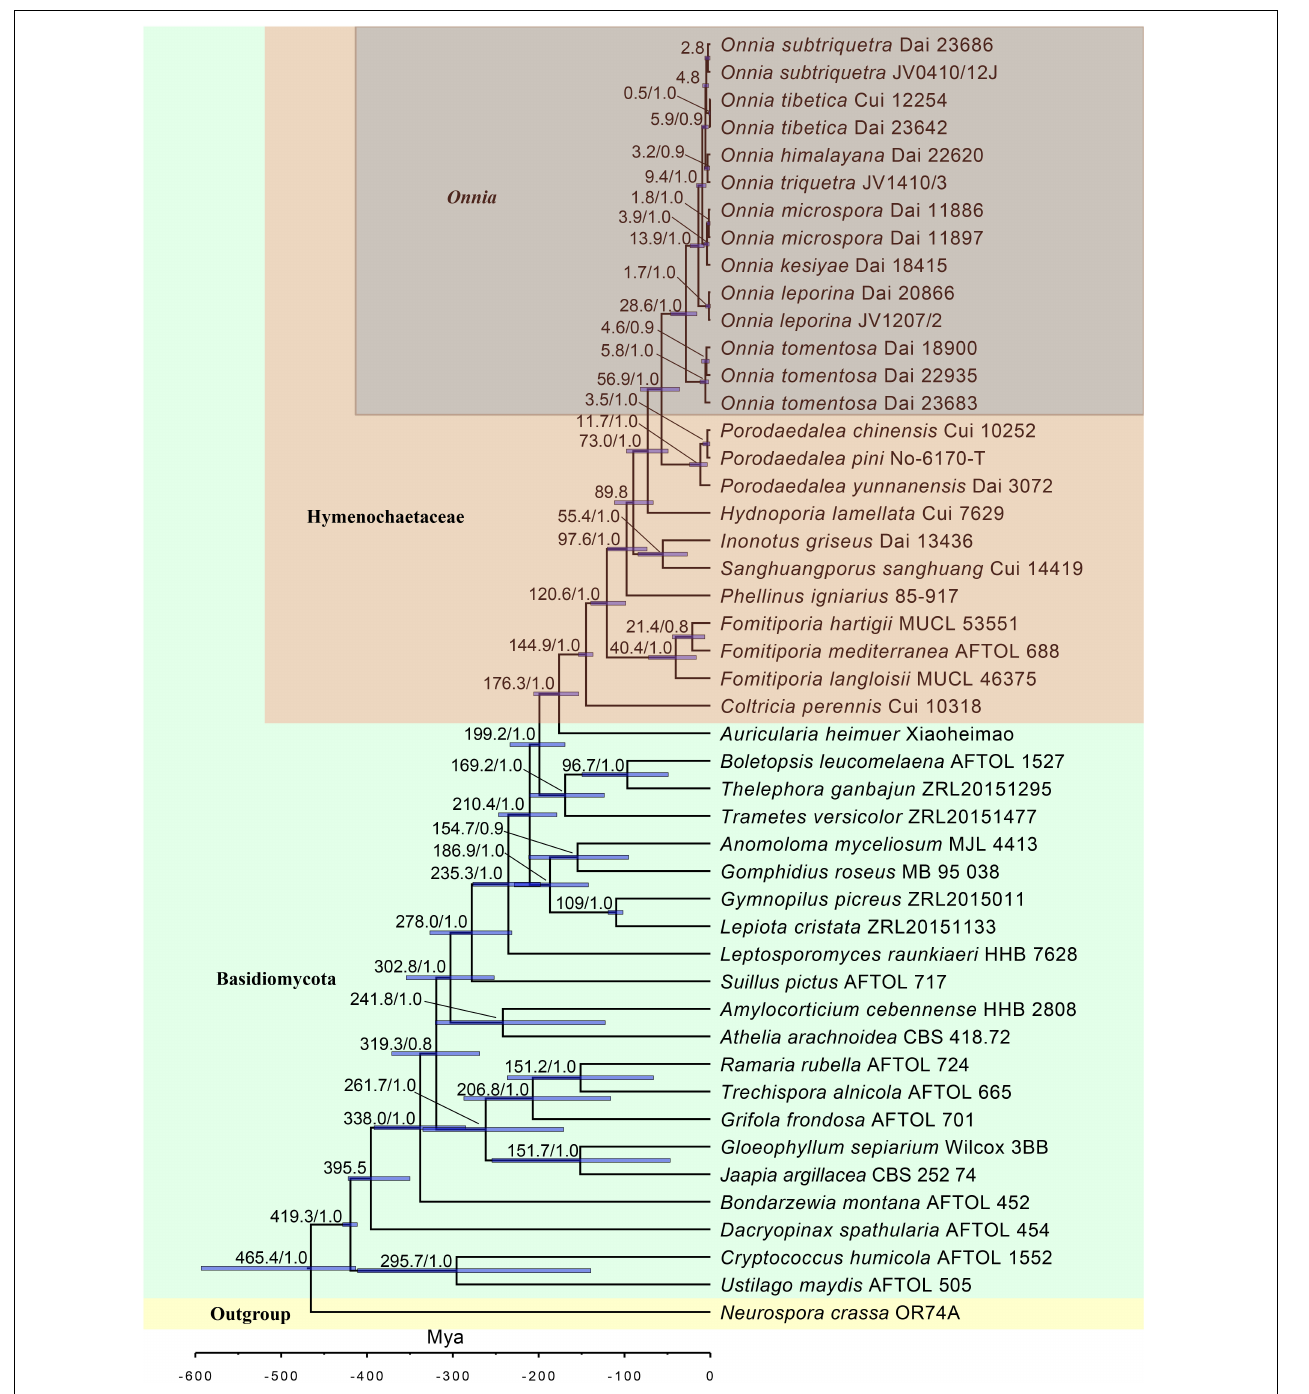
FIGURE 2 | Estimated divergence of Onnia generated from molecular clock analyses using a combined dataset of ITS, LSU rDNA, rpb1 , rpb2 , and tef1 α sequences. Estimated mean divergence time (Mya) and posterior probabilities (PP) > 0.8 are annotated at the internodes. The 95% highest posterior density (HPD) interval of divergence time estimates is marked by horizontal blue